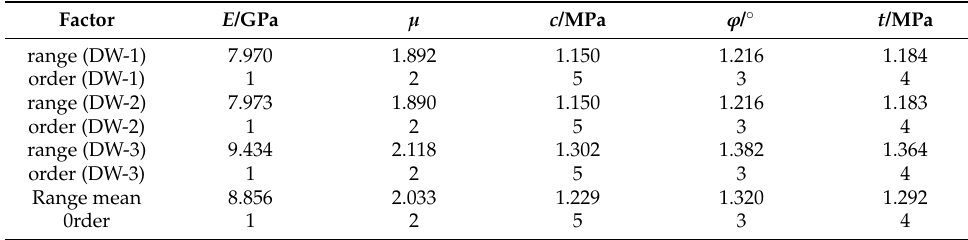
Table 5. Numerical calculation results